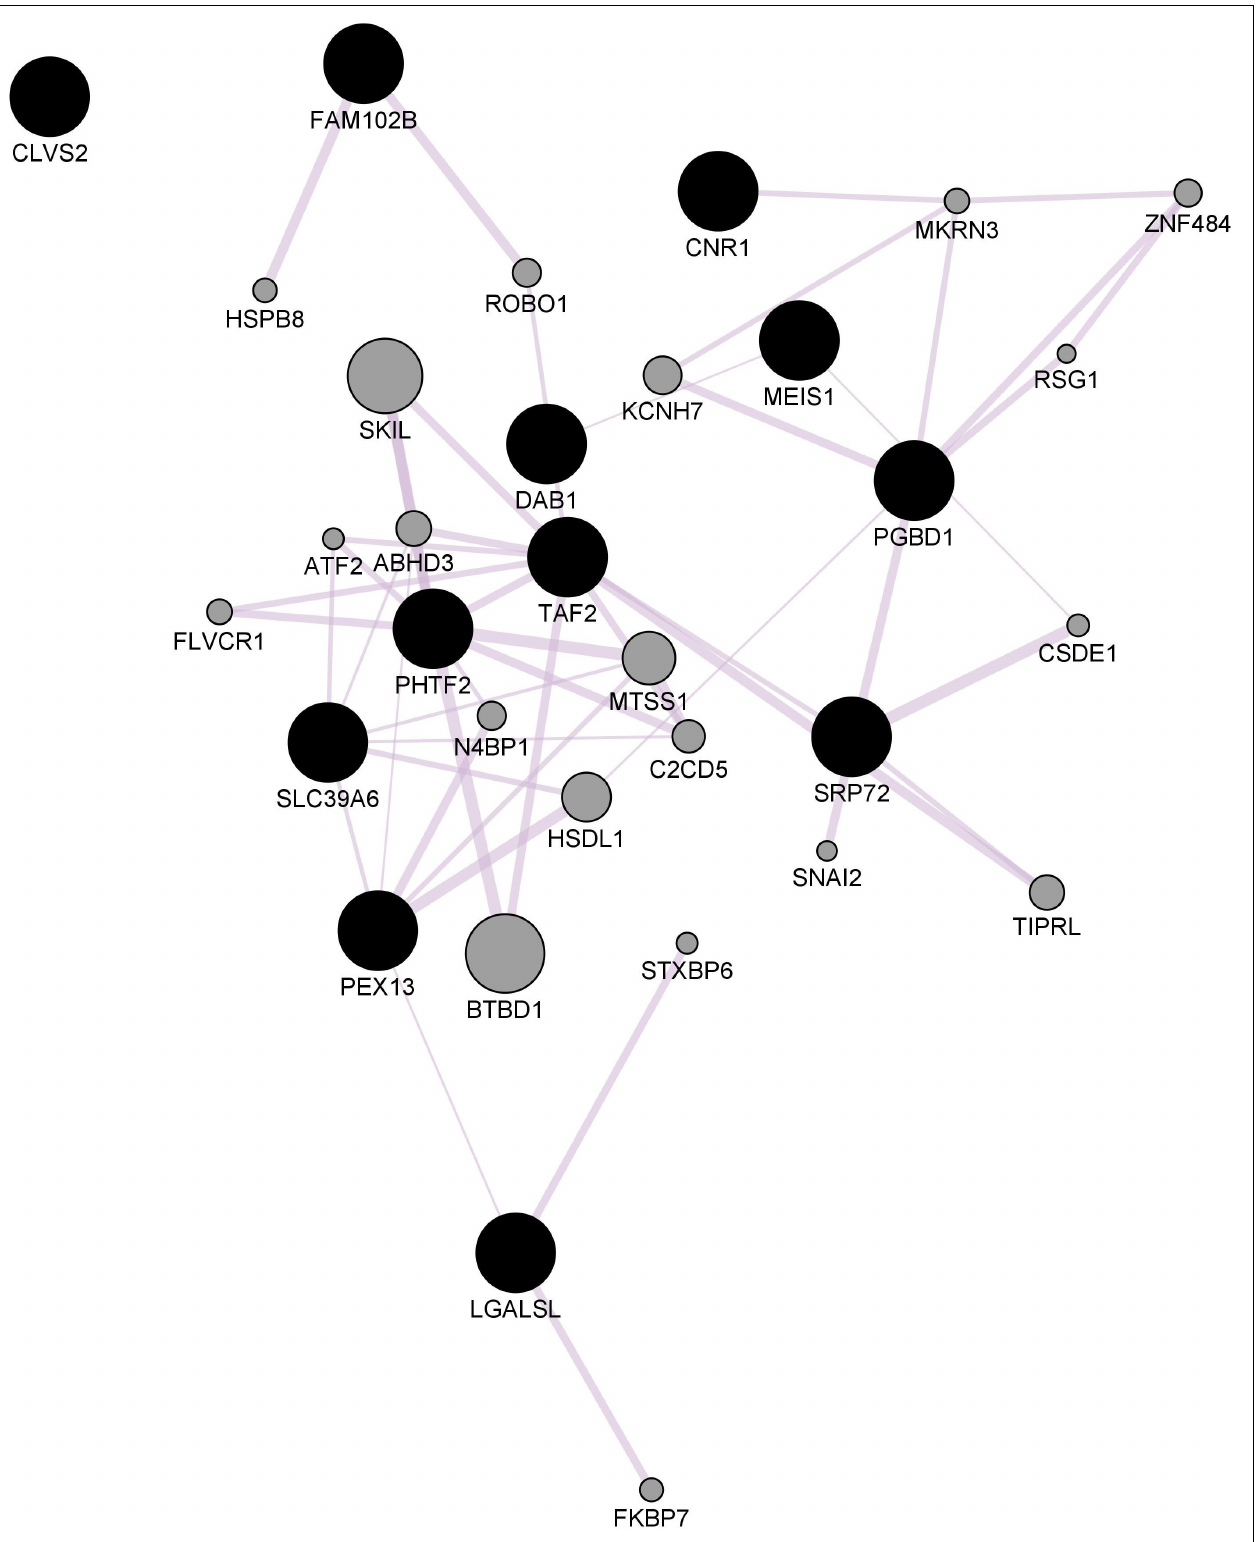
FIGURE 2 | Striatal CNR1 gene network using GeneMANIA. Black circles indicate query genes, whereas gray circles indicate related genes added by GeneMANIA. Node sizes represent gene scores, reflecting how often paths that start at a given gene node end up in one of the query genes.